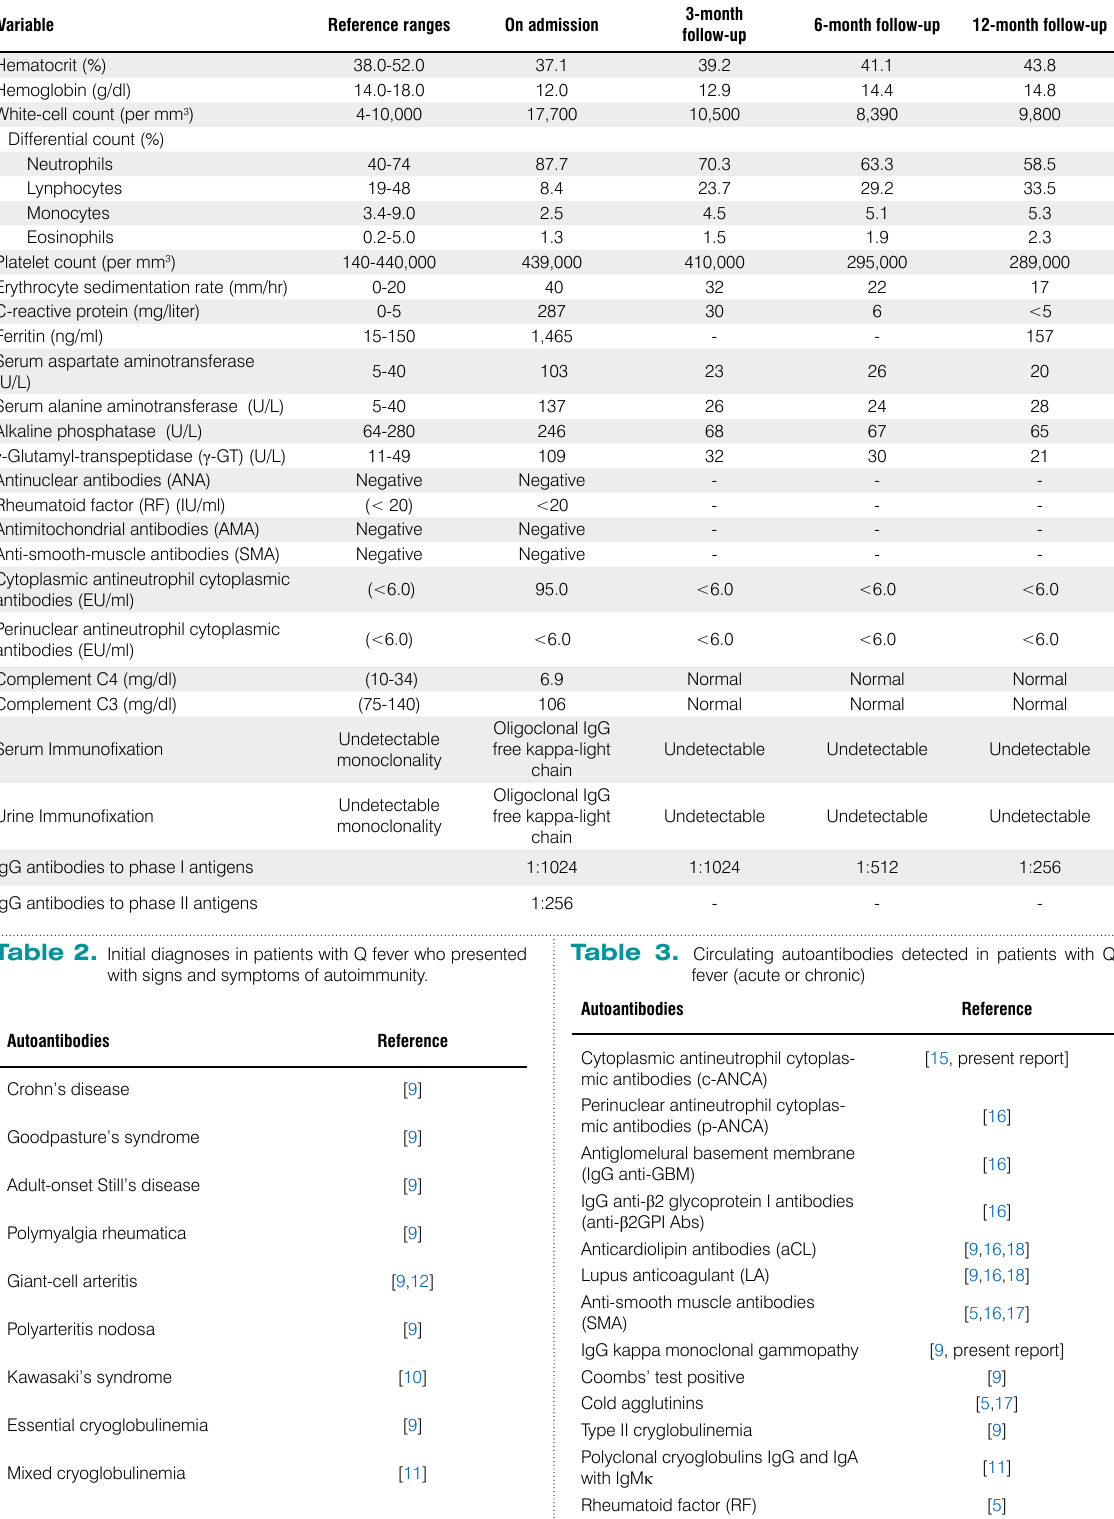
Table 1. Laboratory data.